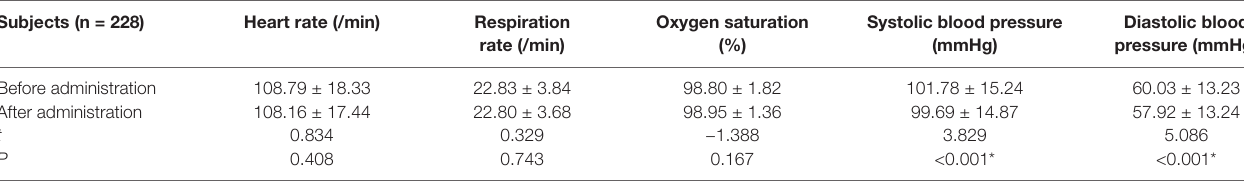
TABlE 2 | The vital signs of the combined anesthetic participants.